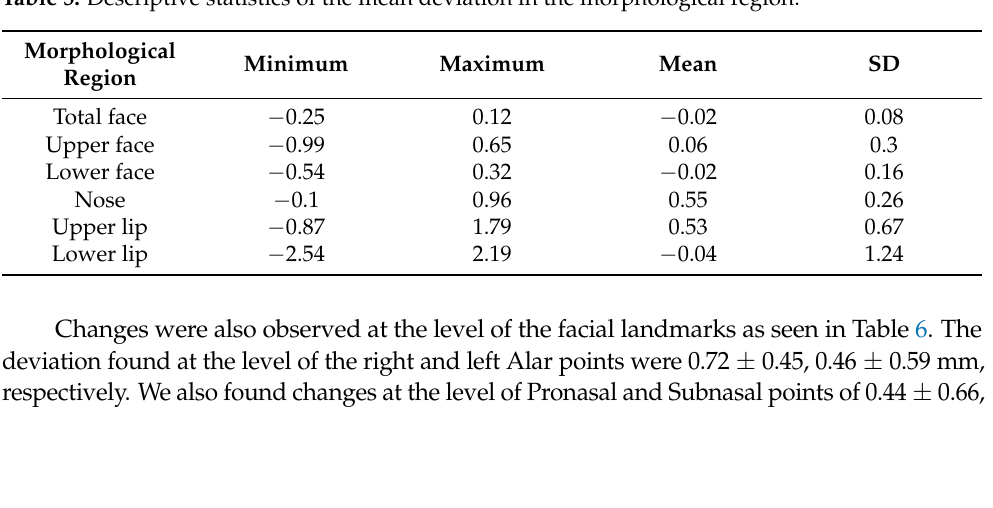
Table 5. Descriptive statistics of the mean deviation in the morphological